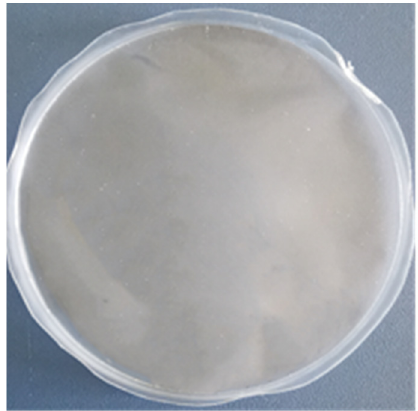
Figure 2. Image of UiO-66@HNT/Pebax mixed matrix membrane.